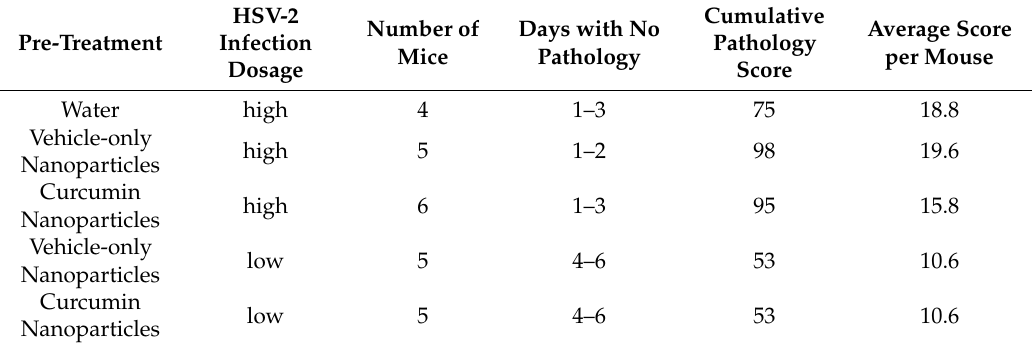
Table 3. Cumulative pathology for mice pre-treated intravaginally with curcumin nanoparticles and infected with high- or low-dose